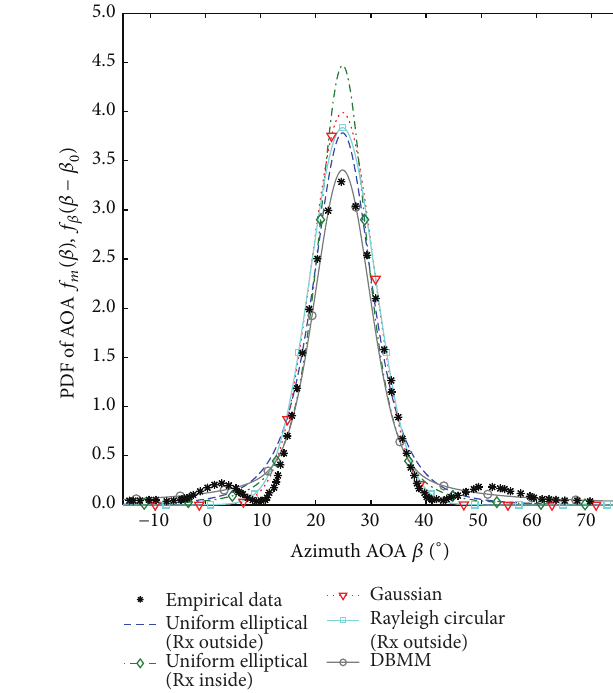
Figure 6: Fitting for various geometric models to the empirical data in Kuchar et al. [28, Figure 3 ].